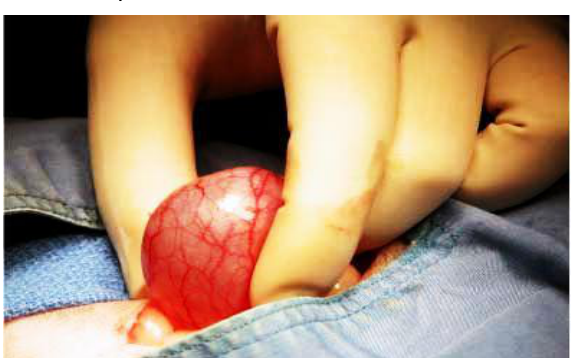
Figure, 1: Urinary bladder is exteriorized out of the laparotomy incision.